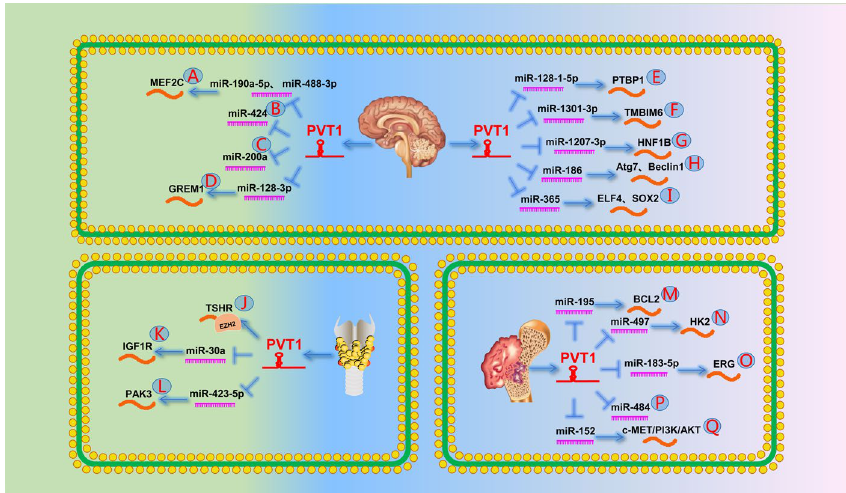
Fig. 8 The role of PVT1 in the other systems. A PVT1 promotes the expression of MEF2C by targeting miR-190a-5p and miR-488-3p. B PVT1 can directly target miR-424. C PVT1 can directly target miR-200a. D PVT1 promotes the expression of GREM1 by targeting miR-128-3p. E PVT1 promotes PTBP1 by targeting miR-128-1-5p. F PVT1 promotes TMBIM6 by targeting miR-1301-3p. G PVT1 promotes HNF1B by targeting miR-1207-3p. H PVT1 promotes Atg7 and Beclin1 by targeting miR-186. I PVT1 promotes the expression of ELF4 by targeting miR-365 to regulate the expression of SOX2. J PVT1 represses its expression by recruiting EZH2 to the promoter region of TSHR. K PVT1 can directly target miR-30a. L PVT1 promotes the expression of PAK3 by targeting miR-423-5p. M PVT1 promotes the expression BCL2 by targeting miR-195. N